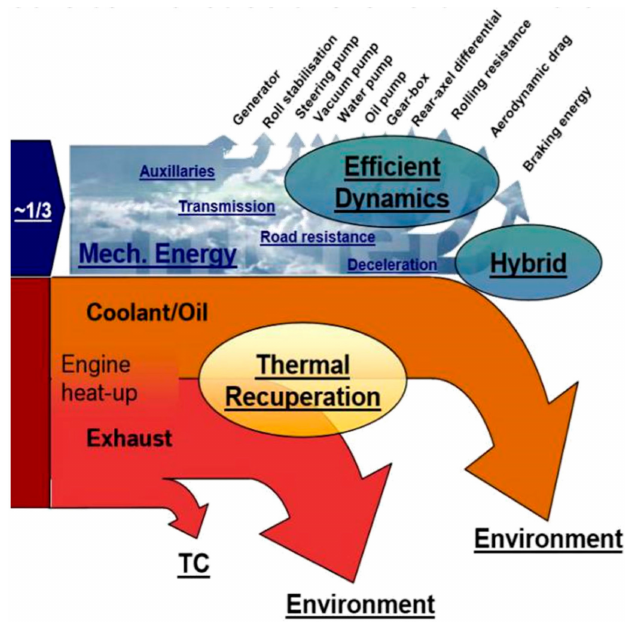
Figure 3. Energy E ffi ciency in Vehicles [25].